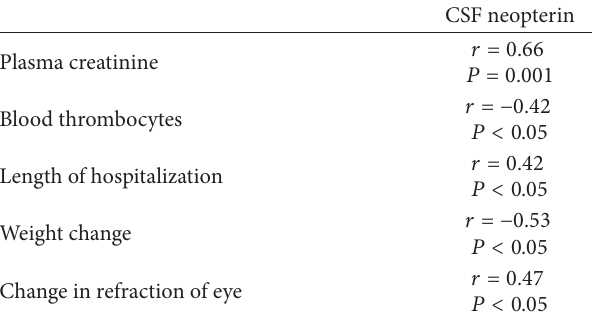
Table 2: Summary of the statistical correlation between the CSF neopterin concentration and plasma creatinine and blood thrombo- cyte count measured in the morning of lumbar puncture, duration of hospitalisation, weight change during the hospitalisation, and change in the refractory properties of an eye between the acute- phase and one month